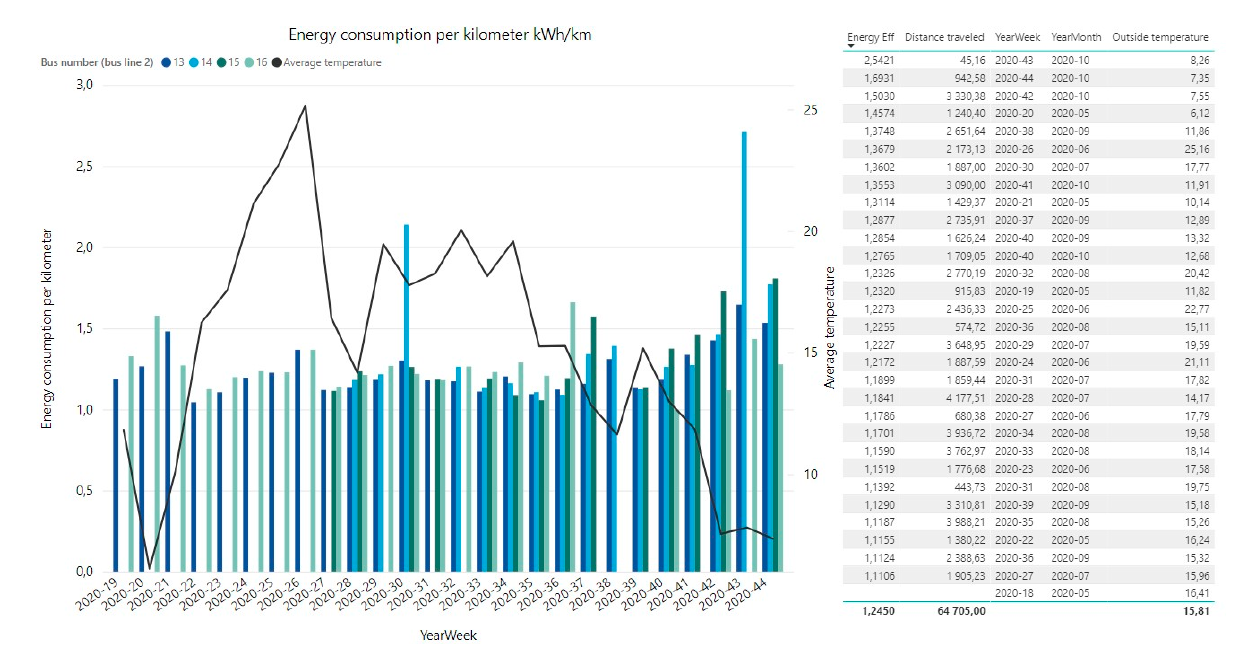
Figure 5. Energy efficiency and outside temperature per week during 1 May 2020–31 October 2020. Power BI used in the visualization followed the grammar rules of the Finnish language.